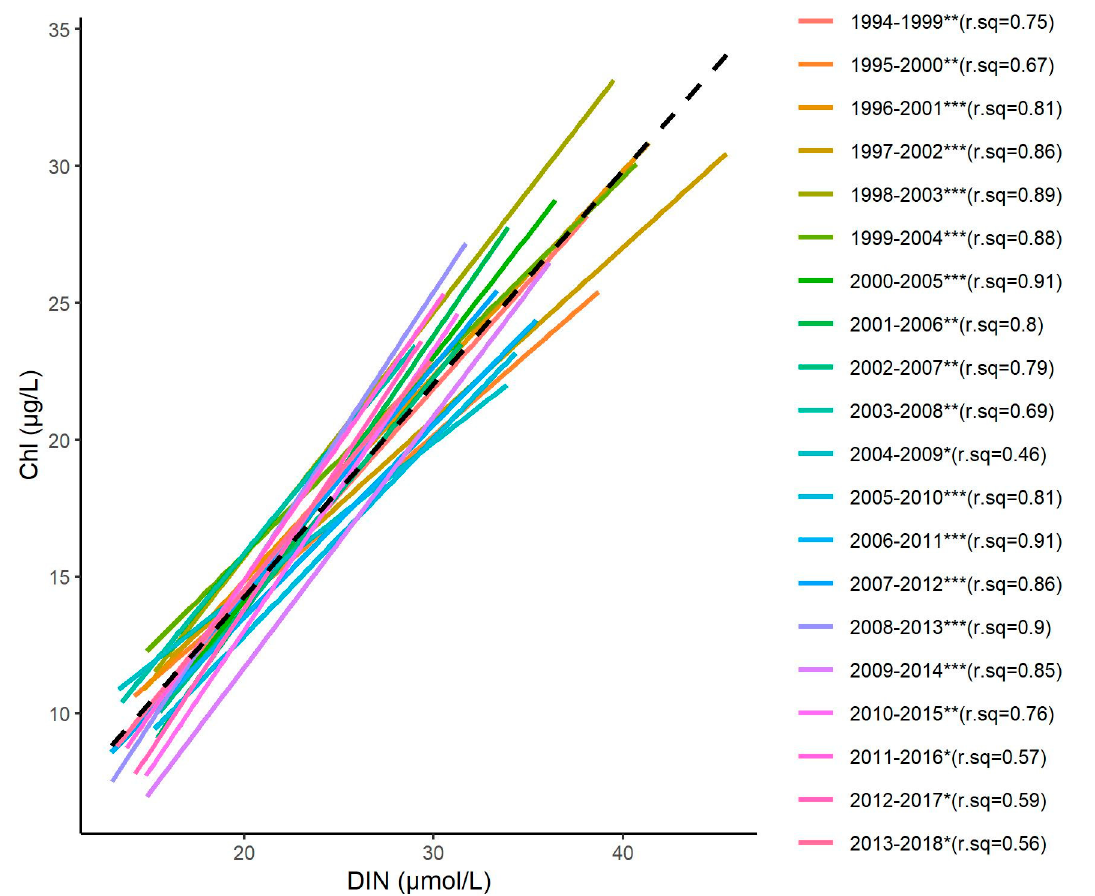
Figure 7. Linear regressions of the relationship between Chlorophyll- a (Chl- a ) and Dissolved Inorganic Nitrogen (DIN) concentrations by six-year sliding period. Input values for both variables are averaged maxima by period, calculated during the growing season for Chl-a and during the winter season for DIN. p -values as well as r-squared are indicated in the legend, next to each corresponding period (0 ‘***’ 0.001 ‘**’ 0.01 ‘*’ 0.05 ‘.’ 0.1 ‘ ’